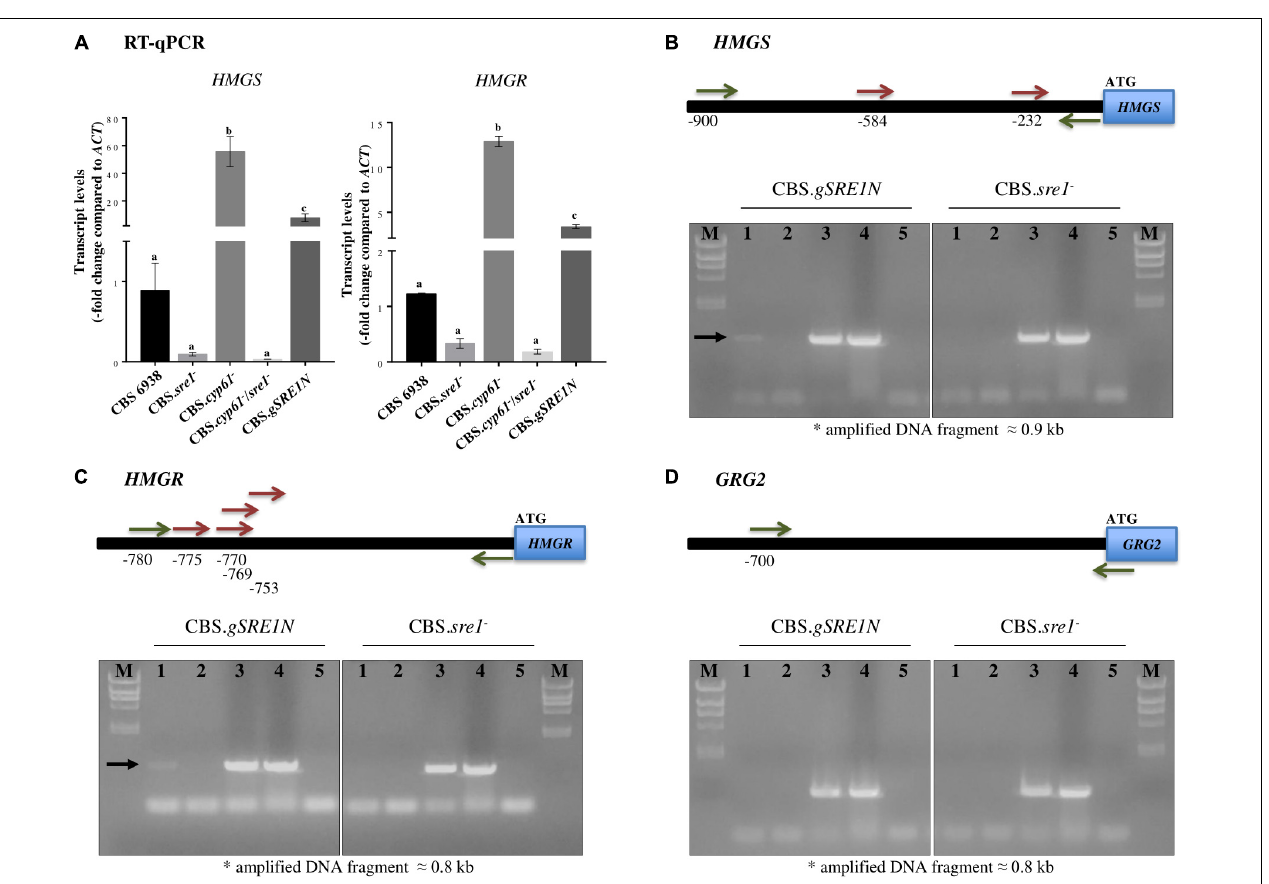
FIGURE 7 | HMGS and HMGR relative transcript levels, and X. dendrorhous Sre1 DNA-binding in vivo . (A) Relative expression of genes HMGS [GenBank: MK368600] and HMGR [GenBank: MK368599]. The transcript levels were evaluated by RT-qPCR after 120 h of culture in YM rich medium with constant agitation and normalized to the housekeeping β -actin gene [GenBank: X89898.1]. Values are the mean ± standard deviation of three independent cultures. (One-way ANOVA and Tukey post hoc test; different letters indicate significant differences among strains with p < 0.01). ChIP-PCR assays of the (B) HMGS , (C) HMGR and (D) grg2 genes from X. dendrorhous . Top: Representation of the amplified region of the promoter (horizontal black bar) of each gene. Predicted Sre1 binding sites (SRE: 5 (cid:48) -BPyCACNCCAPy-3 (cid:48) ; B: any base except thymine, Py: pyrimidine and N: any base) are represented by red arrows; two SREs were predicted at the HMGS promoter (SRE 1: –584/CGTCTCCTGAC/–574 and SRE2: –232/TGTAACACCAC/–222), four at the HMGR promoter (SRE1: –775/TGTGACCTCAC/–765, SRE2: –770/CCTCACGTGAC/–760, SRE3: –769/CTCACGTGACTA/–758 and SRE4: –753/CGACACGTGTG/–743) and none at the grg2 promoter. Primers used in the PCR analyses are represented by green arrows. Bottom: PCR products after ChIP of strains CBS.g SRE1N (mutant expressing the SRE1 (residues 1–524) gene fragment encoding the N-terminal domain of Sre1 fused to 3 copies of the FLAG -3xDYKDDDDK- epitope encoding sequence) and CBS. sre1 - (deletion mutant of SRE1 used as a negative control strain). PCR reactions were performed: lanes: (1) ChIP assay (positive results are indicated by a black arrow), (2) ChIP assay without including the antibody, (3) input DNA, (4) genomic DNA from the wild-type yeast strain CBS 6938, (5) without DNA. M: Lambda Hind III marker (23.2, 9.4, 6.6, 4.4, 2.3, 2.0, and 0.6